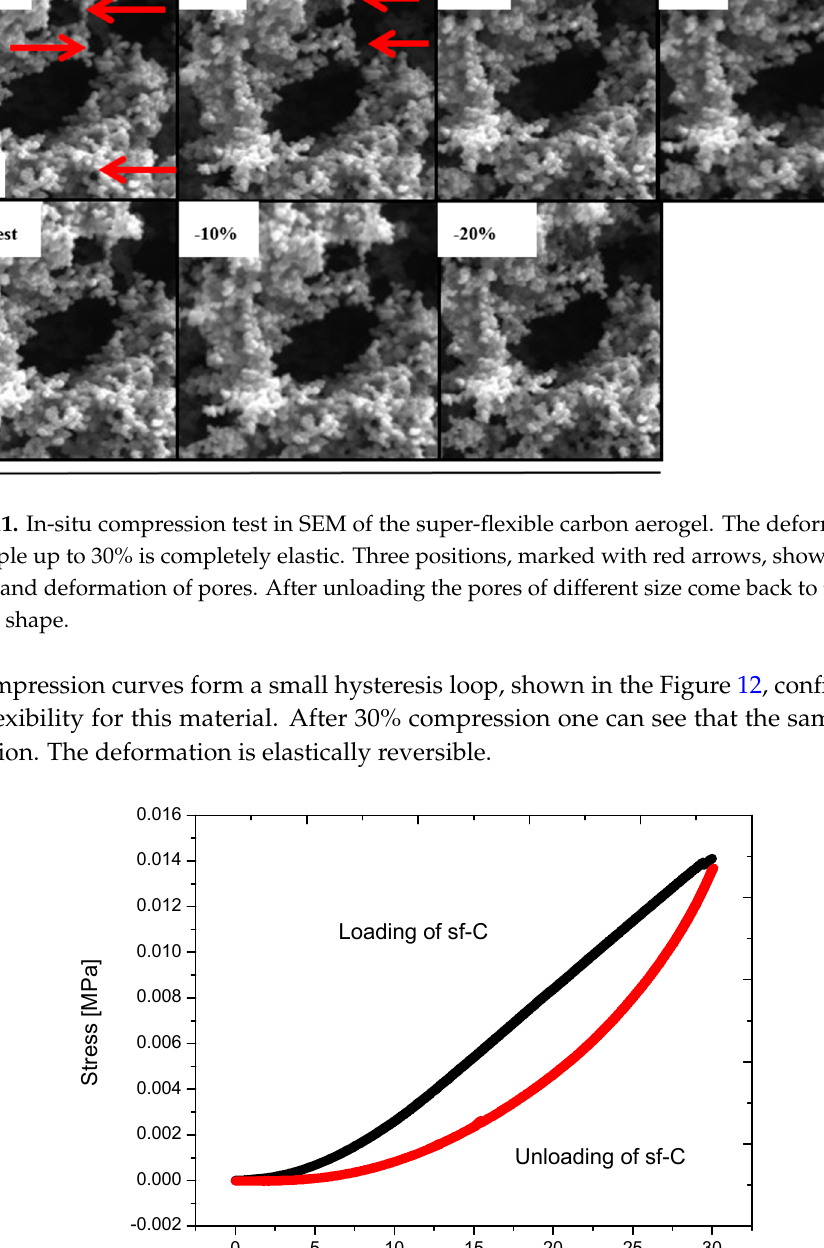
Figure 12. Loading and unloading curves of the super-flexible carbon aerogel showing reversible deformation after 30% compression.